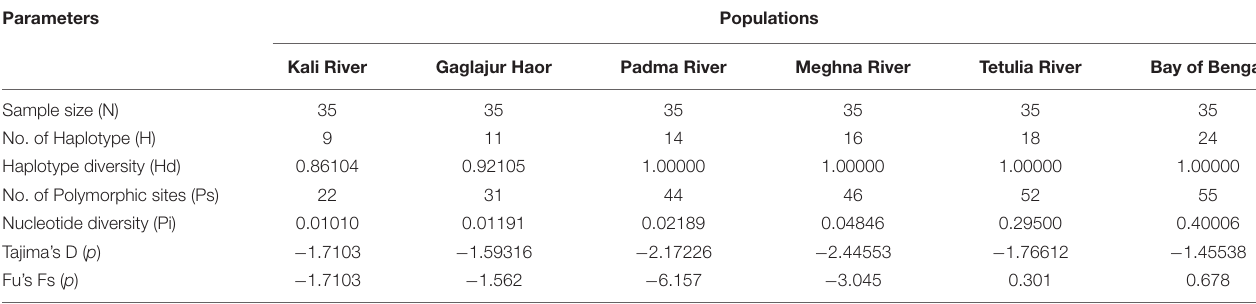
TABLE 3 | Genetic diversity among the six different populations of hilsa shad, T. ilisha .